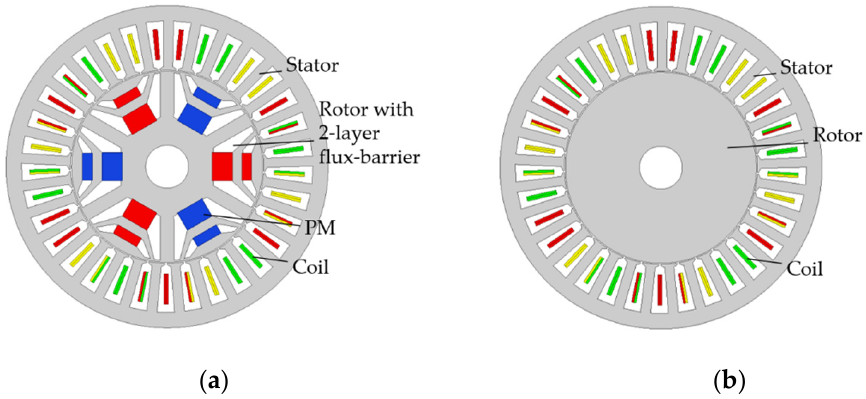
Figure 4. 2D − model structure of two motors: ( a ) motor with two − layer flux − barrier and PM; ( b ) motor without flux − barrier.